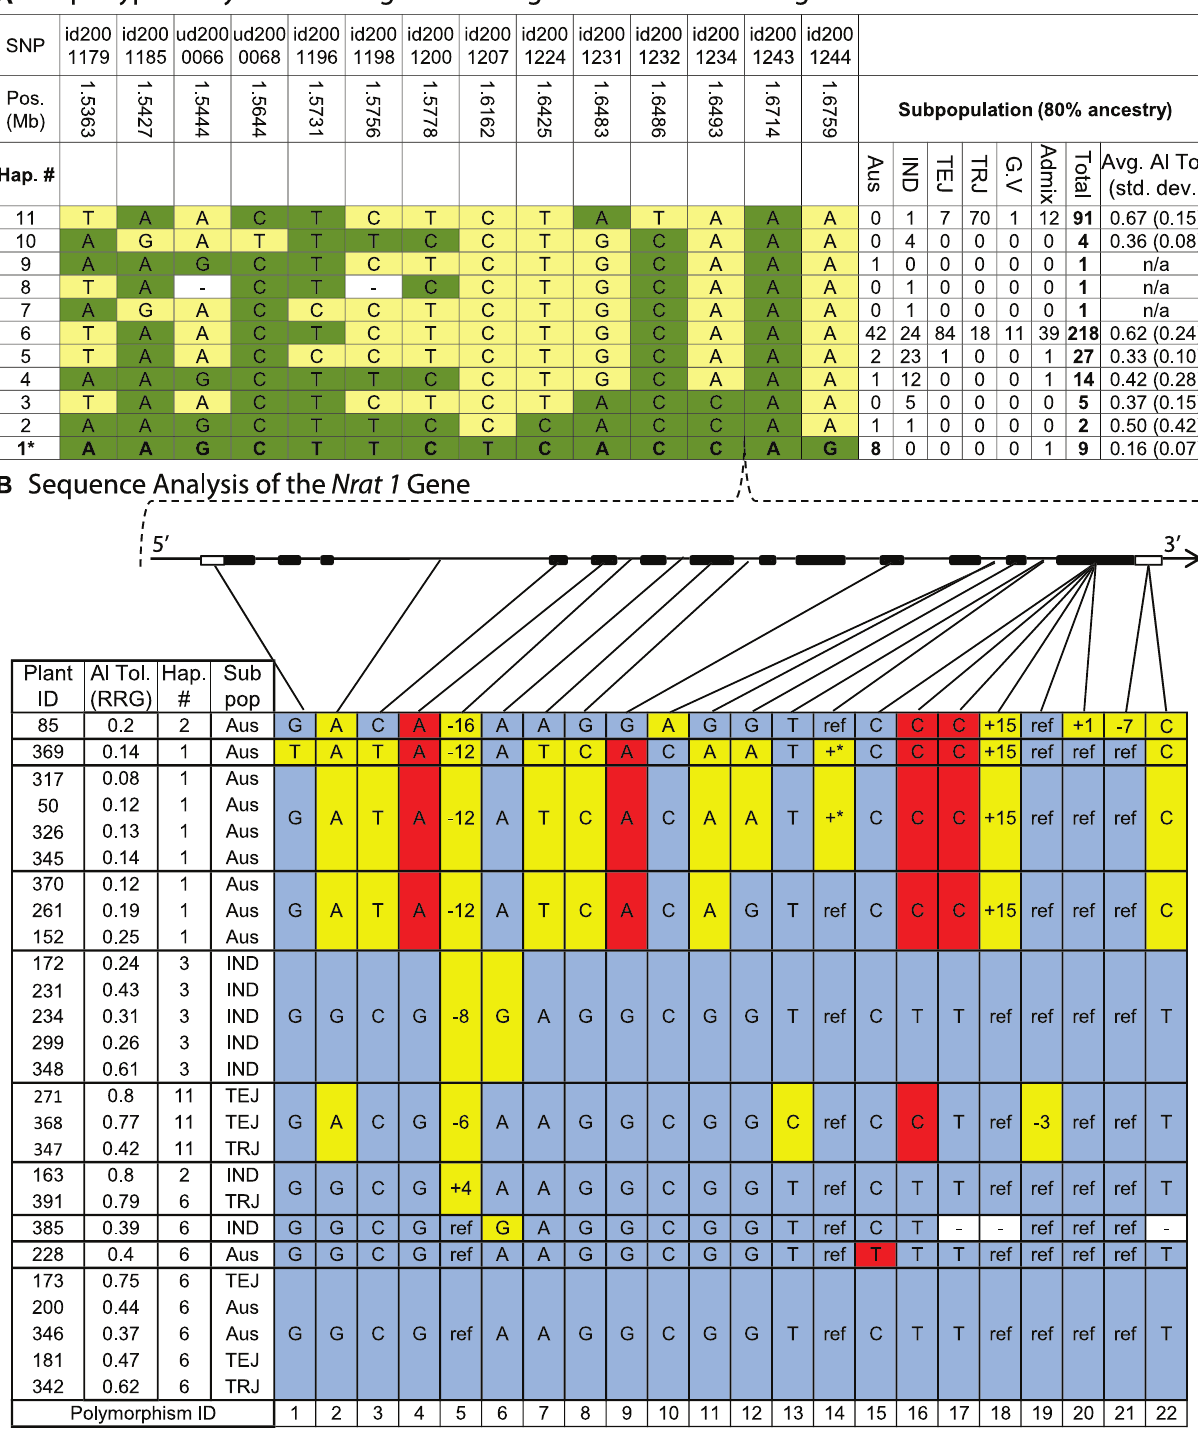
Figure 4. Haplotype analysis of the Nrat1 gene region. A) Haplotypes observed in 373 accessions using the 44,000 SNP data. Haplotype 1 was unique to aus ancestry and associated with Al susceptibility within the aus subpopulation, explaining 40% of the Al tolerance variation within aus. Haplotypes 1, 2, and 3 share the same 4-SNP haplotype (id2001231-id2001243) flanking the Nrat1 gene (1.66 Mb). SNP positions are based on MSU6 annotation and subpopulations are abbreviated as follows: IND= indica , TEJ= temperate japonica , TRJ= tropical japonica , G.V.= groupV / aromatic , Admix=admixed lines without 80% ancestry to any one subpopulation. B) Haplotypes at the Nrat1 gene (1.66 Mb) in the (9) aus and (6) indica accessions sharing the 4-SNP haplotype flanking the Nrat1 gene. Polymorphisms are identified with numbers along bottom of figure. A STOP codon occurs in exon 13 between polymorphism 17 and 18. Gray shaded cells represent the reference allele and plant ID # 173 is the reference genotype ‘Nipponbare’. Yellow shaded cells represent polymorphisms in introns or synonymous polymorphisms in exons. Red shaded cells represent polymorphisms that result in amino acid substitutions (Indel or non-synonymous), unshaded cells marked with ‘‘ 2 ’’ indicate missing data, and + * indicates an intron insertion . 500 bp. doi:10.1371/journal.pgen.1002221.g004 PLoS Genetics |